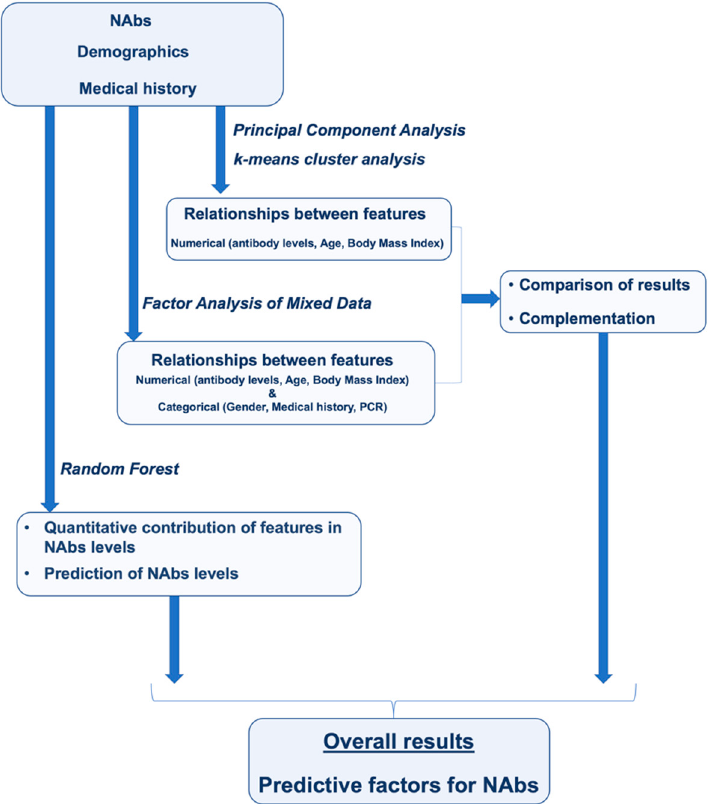
Figure 6. Flowchart presenting the overall route of analysis. The association between neutralizing antibody levels (NAbs) and demographics/medical history was investigated using four machine learning methods: principal component analysis, k-means cluster analysis, factor analysis of mixed data, and random forest.